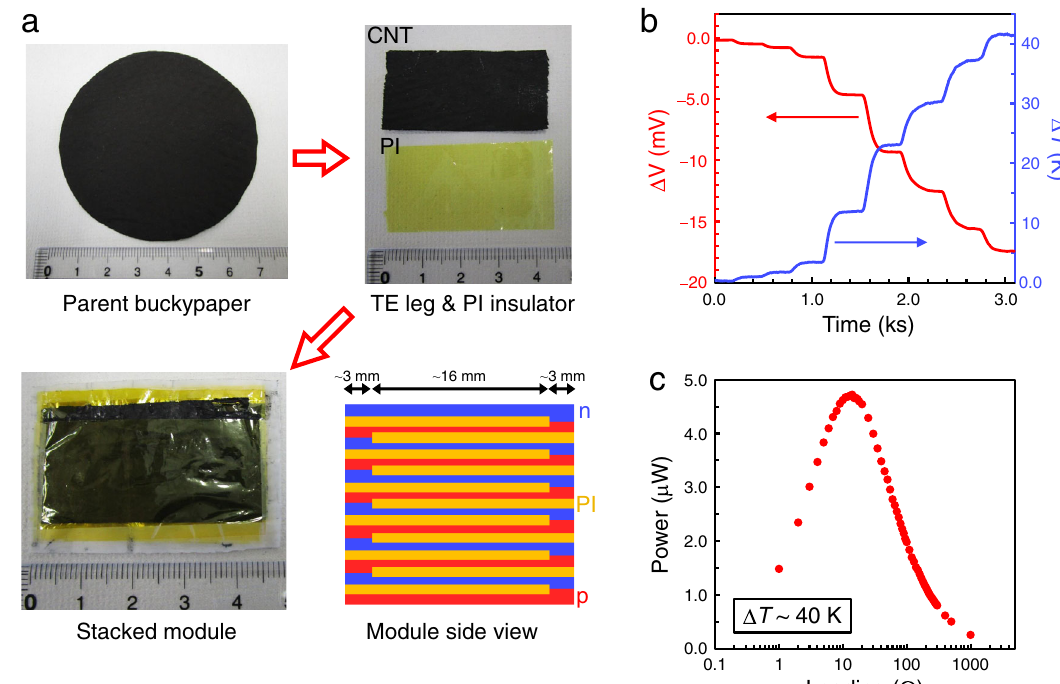
Fig. 8 Demonstration of a CNT-based TE module. a Photographs and schematic. A large piece of parent buckypaper ( ϕ ≈ 73 mm) was produced and cut into a strip of 22 mm × 43 mm. The as-prepared CNTs were used for the p-type TE legs. For the n-type ones, the CNTs were doped using DMF solution of TBD (71 mM). Then, the p- and n-type CNT legs were alternatively stacked and electrically connected at the edges (~3 mm), while polyimide (PI) fi lms (23 mm × 44 mm) were inserted between them for insulation. The module is composed of 6 pairs of p/n couples. b Temporary change in the open circuit voltage ( Δ V ) for the module according to the supplied temperature difference ( Δ T ). The thermopower of the 6-couple module is ca . 415 μ V K − 1 . c Power output from the module at Δ T of ~40 K under varied load connection (electrically in series and thermally in parallel) enables ef fi cient addition of thermopower from each component. The thermopower generated by the module is ca . 415 μ V K − 1 according to the open circuit voltage vs . temperature difference ( Δ T ) data in Fig. 8b. At Δ T = 40 K, the open circuit voltage reached ~17 mV, and the maximum power output of 4.7 μ W was obtained after loading a resistance of 14 Ω , as shown in Fig. 8c. Based on the cross-sectional area of the module (0.0153 cm × 4.3 cm), the maximum power density is 71 μ W cm − 2 , which is good-to-excellent compared to previous all-organic thermoelectric modules. Some of the reported values are: 167 μ W cm − 2 at Δ T = 27.5 K (all-CNT thermoelectric module) 58 , 0.27 μ W cm − 2 at Δ T = 30 K (all-organic module) 59 , 15 nW cm − 2 at Δ T = 45 K (all-polymer disk-shaped module) 60 , and 40 μ W cm − 2 at Δ T = 50 K (natural cooling condition) using a